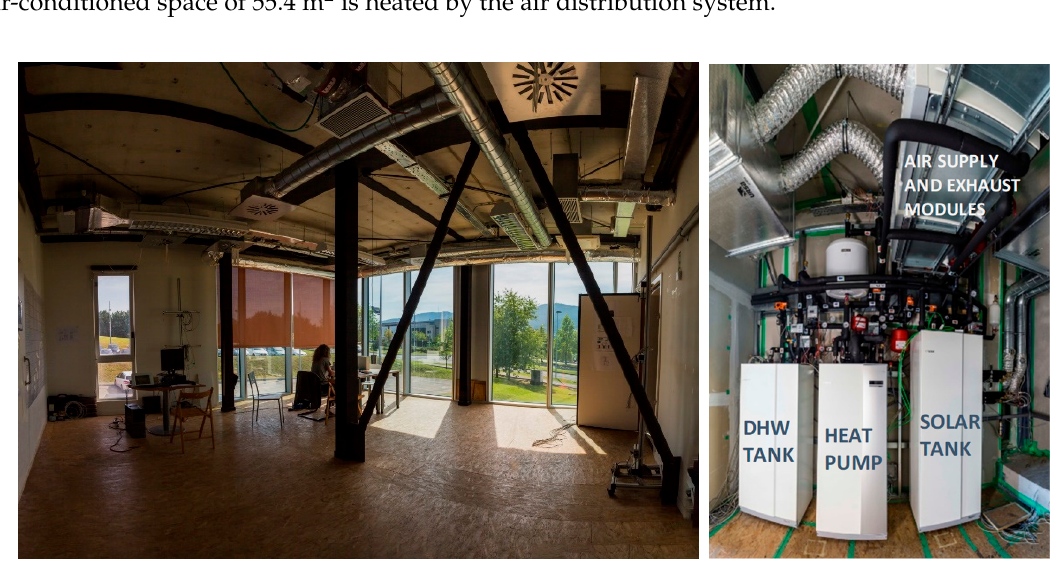
Figure 3. Air-conditioned space ( left ) and utility room ( right ).